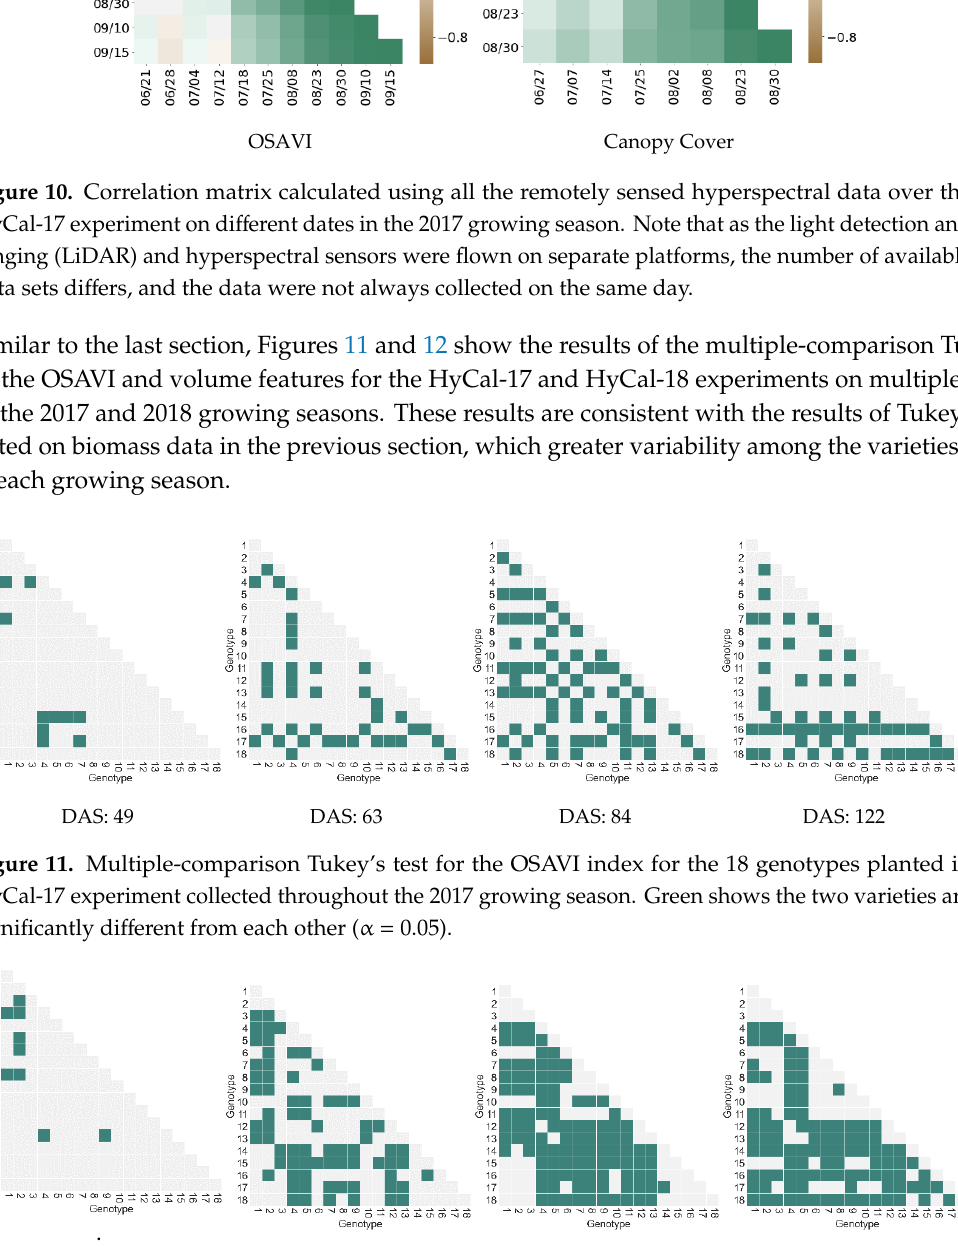
Figure 12. Multiple-comparison Tukey’s test for the LiDAR-based volume for the 18 genotypes planted in HyCal-18 experiment collected throughout the 2018 growing season. Green shows the two varieties are significantly different from each other (α = 0.05).